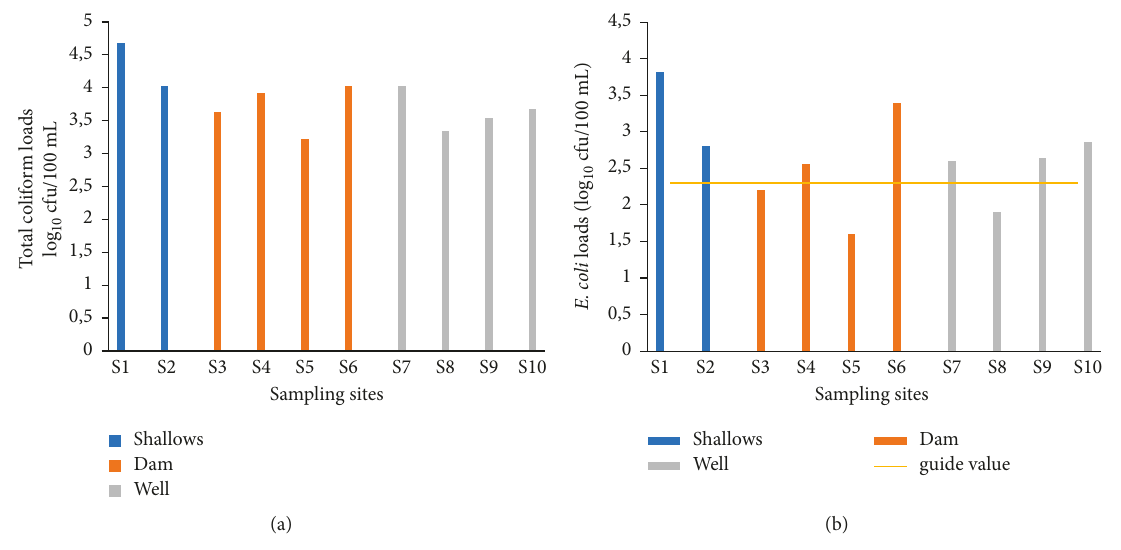
Figure 2: Total coliform (a) and E. coli (b) counts in irrigation water.